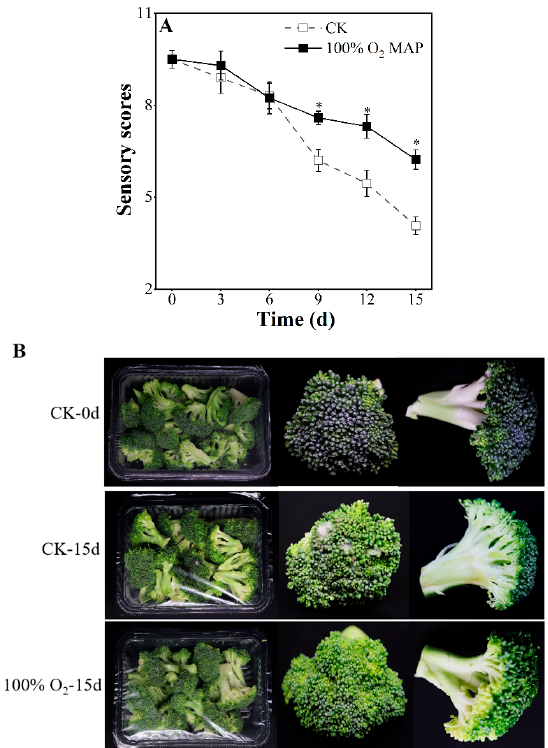
Figure 2. Effect of 100% O 2 MAP on representative sensory scores ( A ), visual photograph ( B ), of fresh-cut broccoli. * in the fi gure indicates signi fi cant di ff erences among treatments at the same storage time ( p < 0.05).